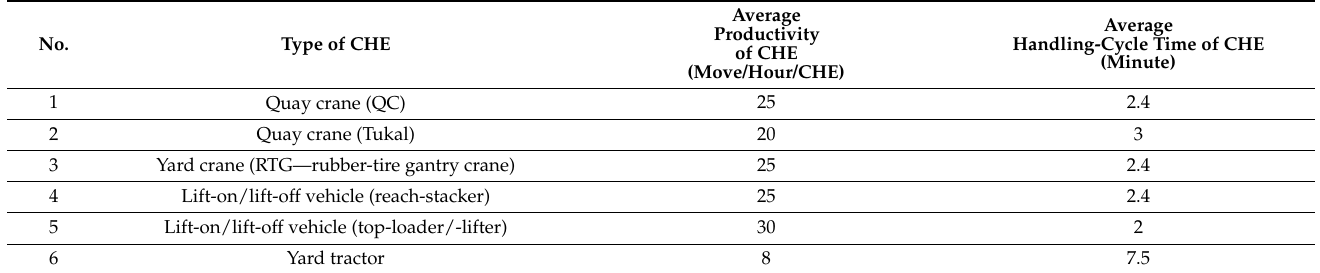
Table 2. Average productivity and average handling-cycle times of some common types of CHEs observed and statistics in surveyed container terminals in